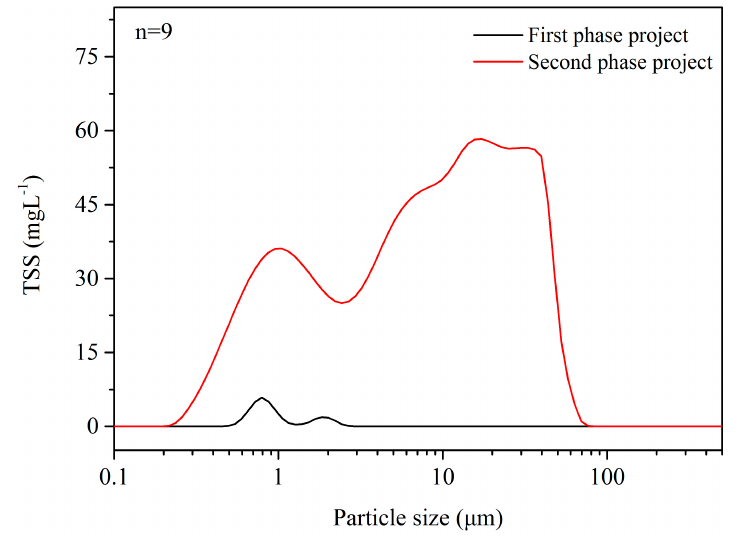
Figure 7. Particle size distribution of leachate from the Wuhan Chen-Jia-Chong landfill.